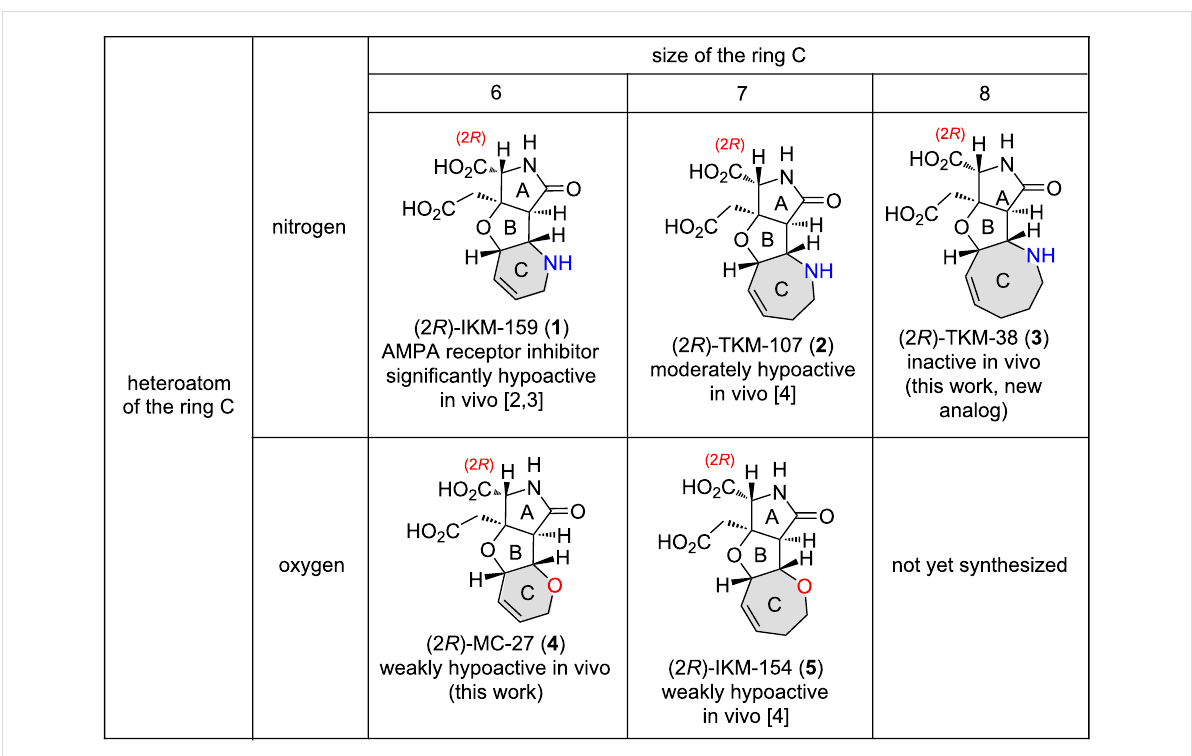
Figure 1: Artificial glutamate analogs synthesized in an enantiomerically pure form.